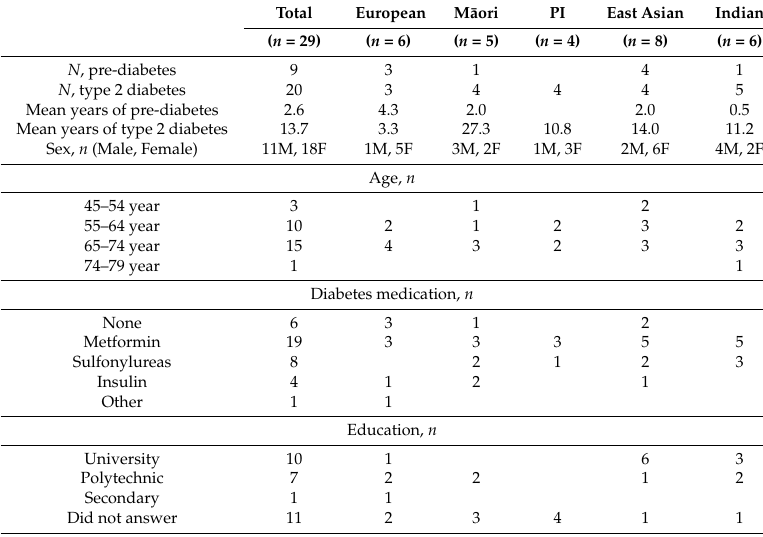
Table 1. Characteristics of the study